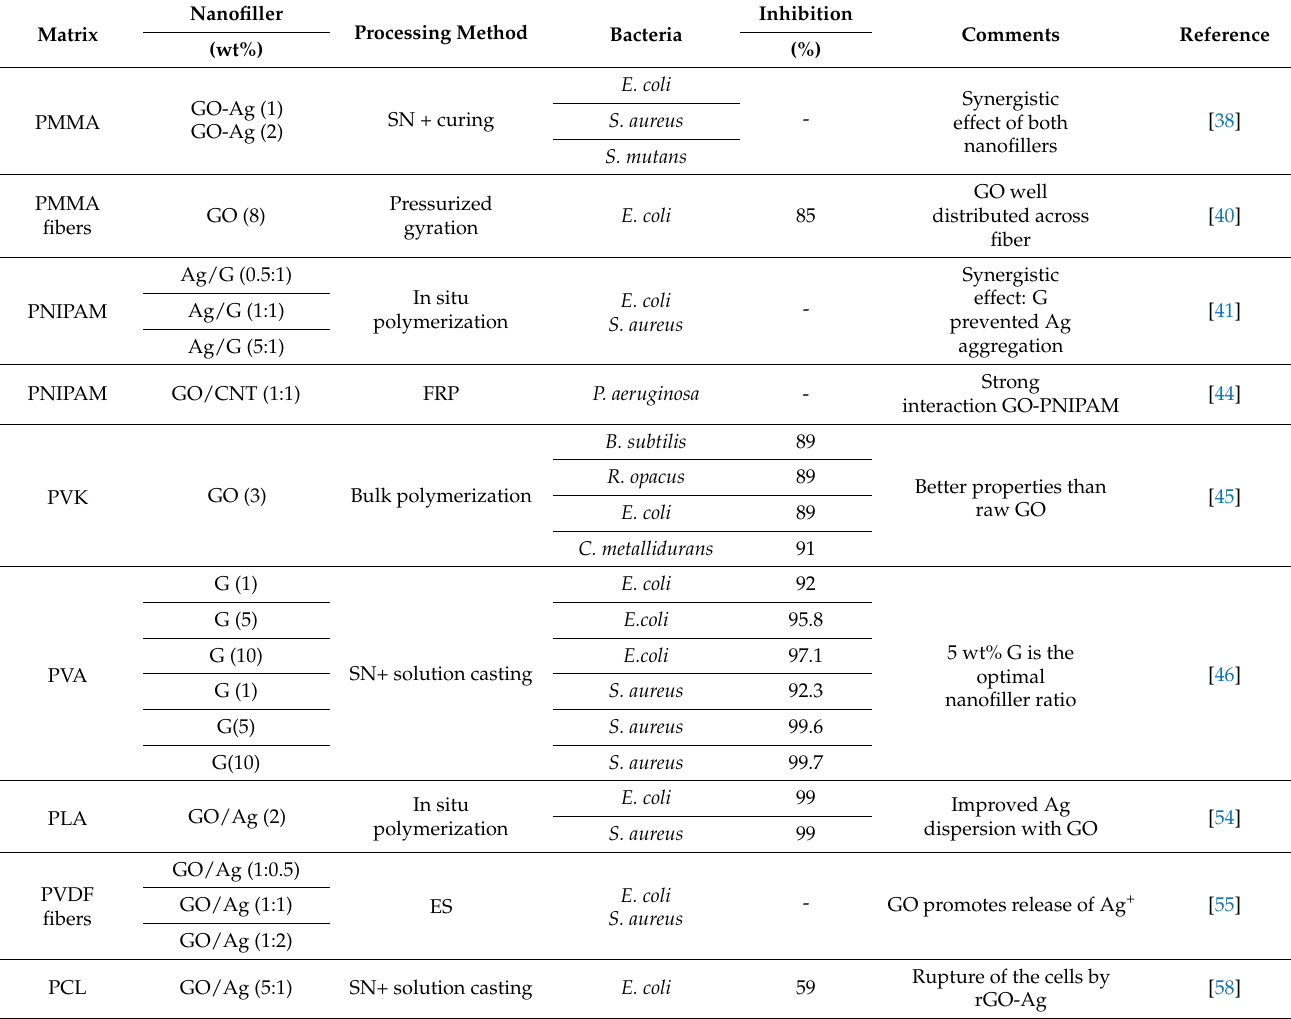
Table 1. Characteristics of polymer nanocomposites with G-based